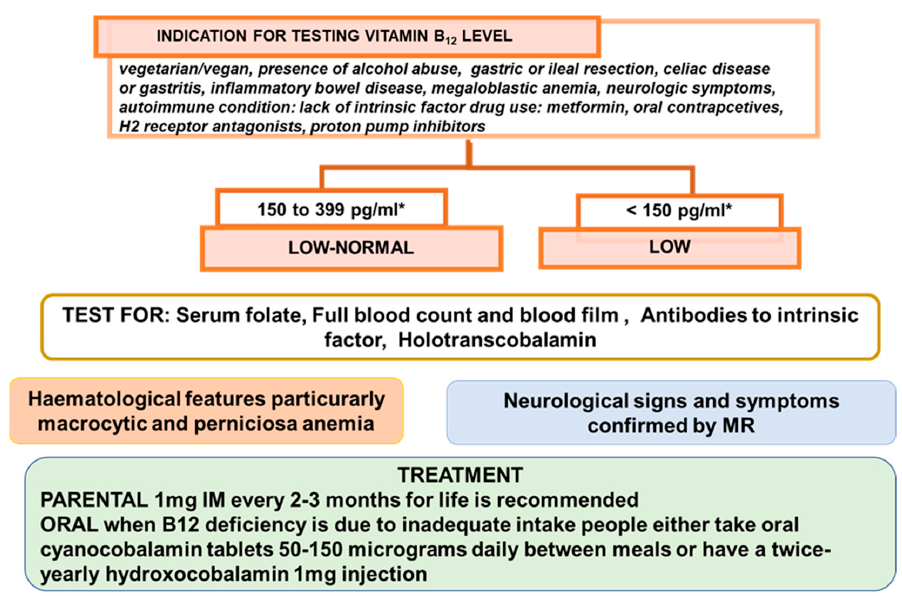
Figure 2. Main conclusions. * According with reference range provided by the local laboratory.